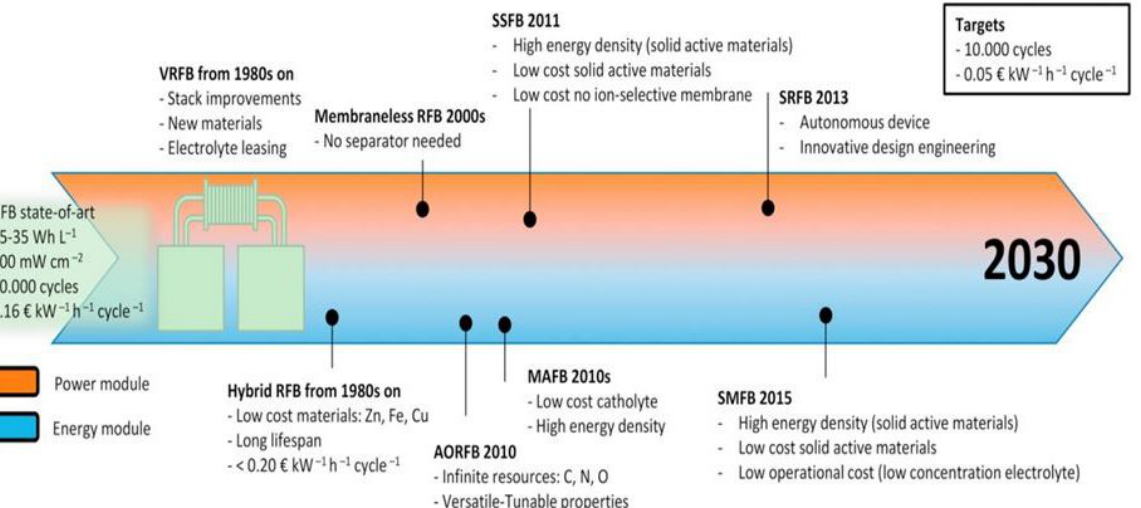
Figure 1. The diagram shows the developmental stages and the present SoA of RFB technology. Adapted from the article written by Sánchez-Díez et al. [1] under a Creative Commons Attribution License 4.0 (CC-BY-NC-ND